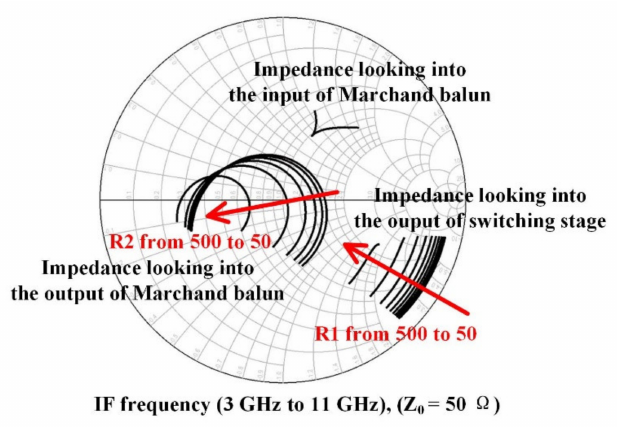
Figure 13. The impedance changes with R1 and R2 at the IF.